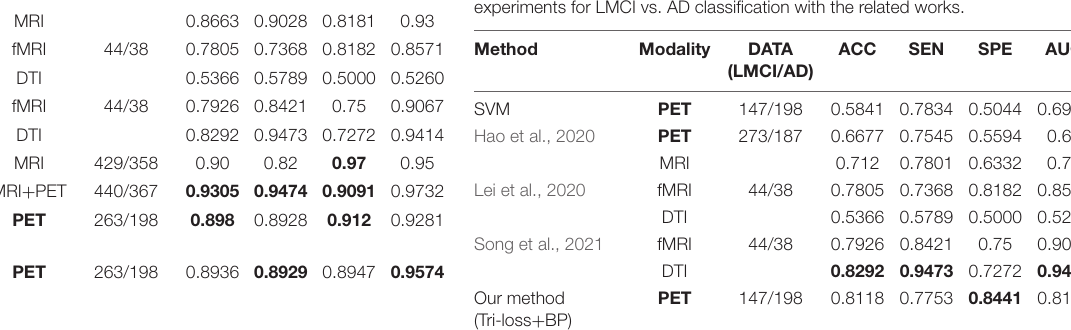
The bold values represent the highest